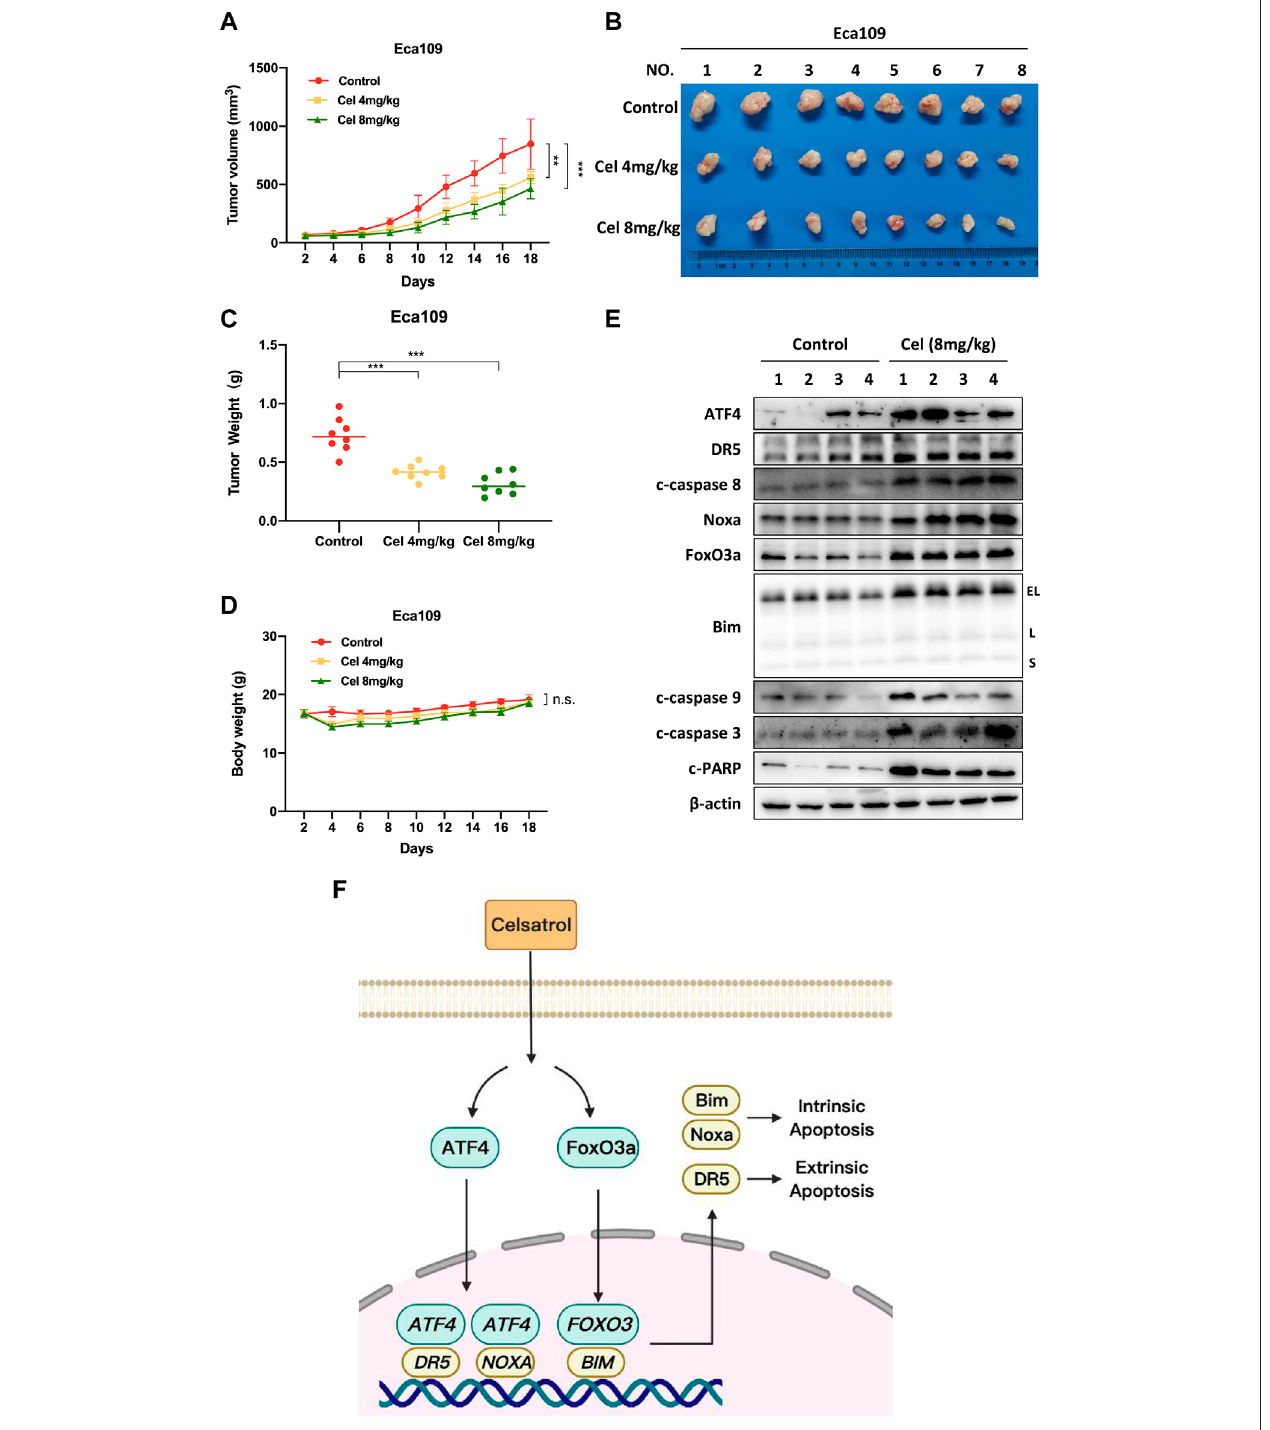
FIGURE 6 | Celastrol suppressed the growth of ESCC in vivo . (A) Nude mice have subcutaneously transplanted Eca109 cells and are treated with celastrol as described in Materials and Methods. Tumor size was determined with a caliper every other day, and the volume was calculated to construct a growth curve. (B) Mice were sacri fi ced, and tumor tissues were harvested and photographed. (C) The tumor weight was measured with an electronic scale on the sacri fi ced day. (D) Body weight ofeach mousewasrecordedeveryotherday during thewholeexperiment. (E) Celastrol induced extrinsic and intrinsic apoptosis invivo .Proteins extracted from tumor tissues were analyzed by Western blotting using speci fi c antibodies against ATF4, DR5, c-caspase 8, Noxa, FoxO3a, Bim, c-caspase 9, c-caspase 3, and c-PARP with β -actinasaloadingcontrol.ThreemajorBimisoformswerecreatedbyalternativesplicing:BimS,BimL,andBimEL. (F) Themechanismofcelastrolinhibits